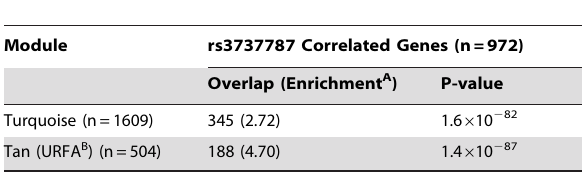
Table 3. Overlap of rs3737787 modules with genes differentially expressed by the rs3737787